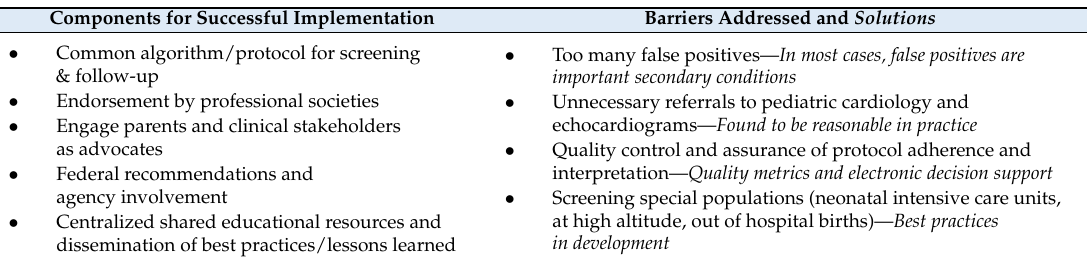
Table A1. Showing Components for Successful U.S. Implementation & Barriers